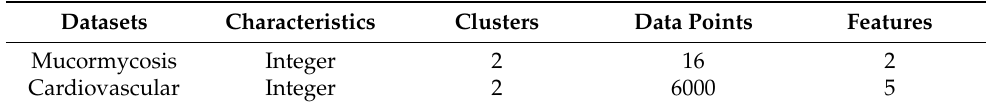
Table 5. Details of the datasets which contain characteristics of each datapoint, the number of clusters, the total number of datapoints and selected